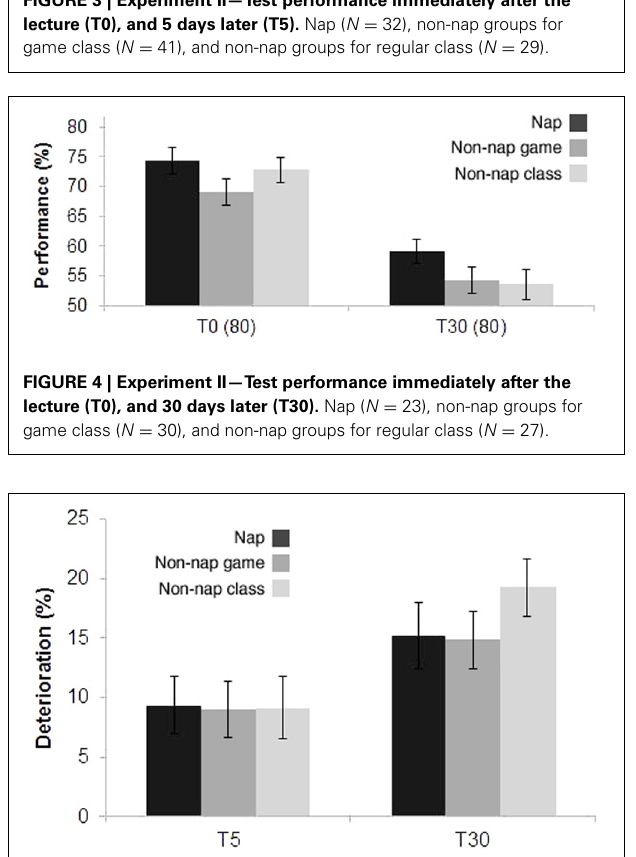
performance ( N = 31 per group). Across all groups, there were no significant differences in the time that students reported to have slept in the night prior to the